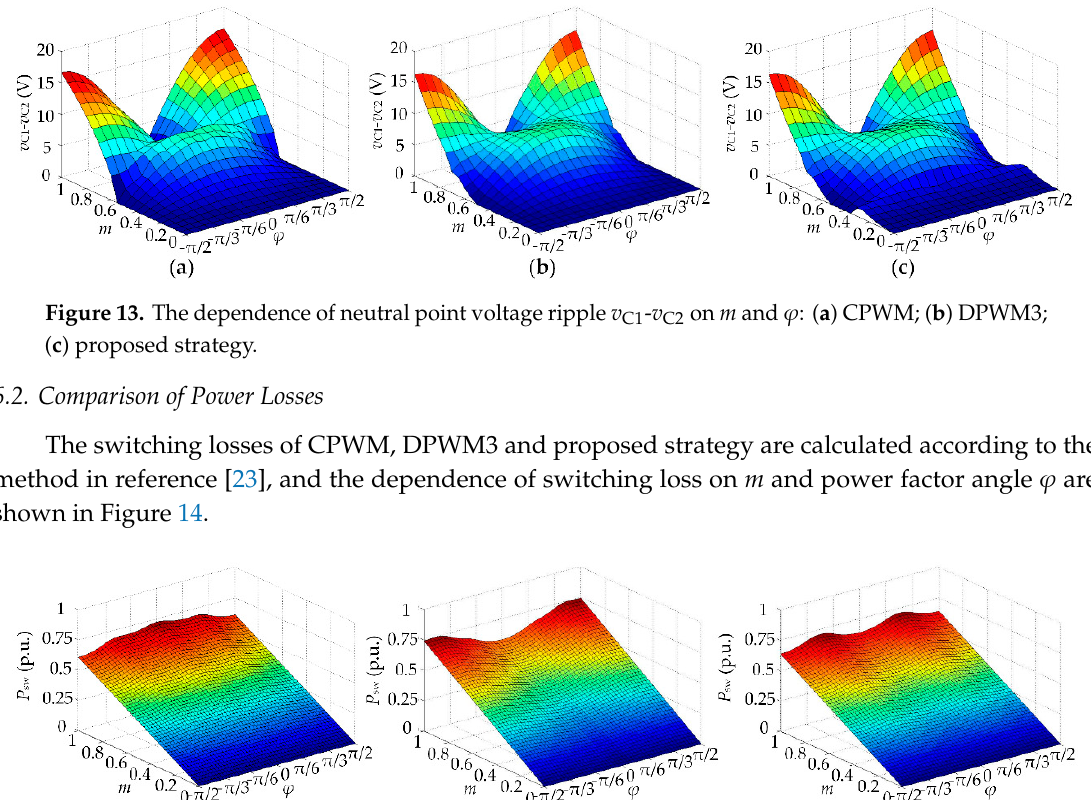
Figure 15. The dependence of I TDD and V WTHD on m for CPWM with neutral-point balancing, VSVPWM, hybrid strategy and the proposed strategy: ( a ) I TDD ; ( b ) V WTHD . 7. Conclusions A sector subdivision based modulation strategy combined with continuous and discontinuous switching sequences has been presented to promote the output performance of three-level inverters. The magnitude of the average current ripple vector was introduced as the performance indicator of the output current ripple. Then the optimal distribution of switching sequences has been derived. Compared with CPWM and DPWM3, the output current ripple of the proposed strategy was reduced. It can be concluded that the output current ripple are reduced significantly under the condition of m < 0.38 and m ≥ 0.8. At the rated frequency, I TDD of the proposed strategy drops by 33% and 3.5%, respectively, compared with CPWM and DPWM3. The power loss of the proposed strategy was medium among those three strategies. Additionally, compared with neutral-point balancing strategies, the improvement of the output waveform quality was also significant.